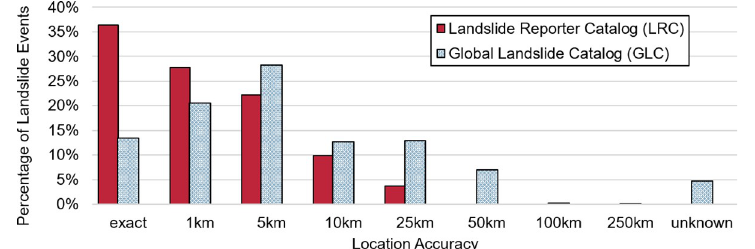
Fig 9. Number of landslide events by location accuracy. The number of landslide events by their “location accuracy” field in the LRC (in red) and the GLC (in blue).